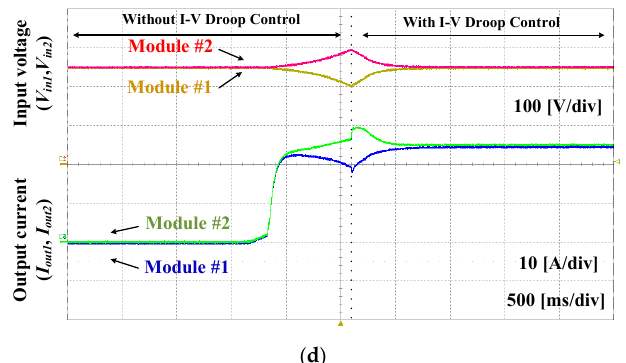
Figure 10. Experimental waveforms with proposed control method. ( a ) The individual input voltages and output current at 10 A; ( b ) individual input voltages and output current at 15 A; ( c ) individual input voltages and output current at 20 A; ( d ) individual input voltages and output current at 25 A.